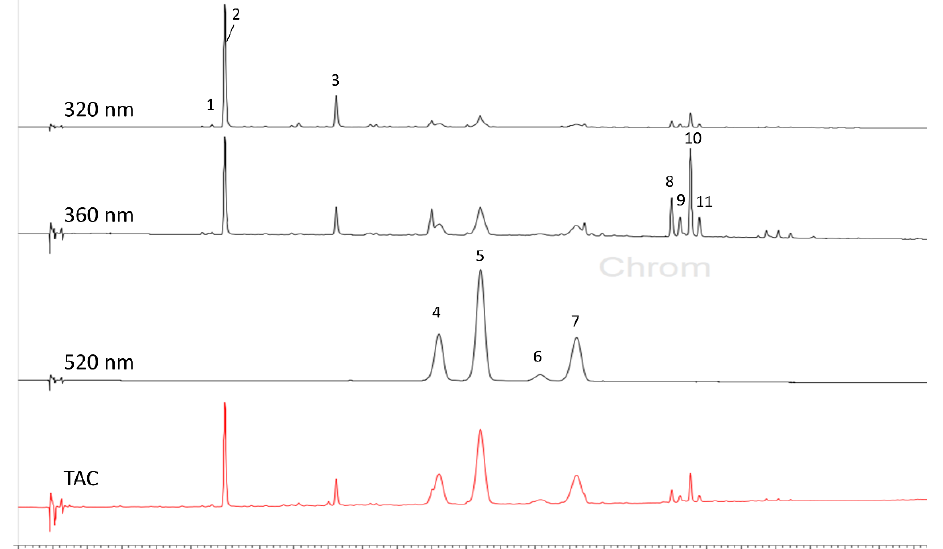
Figure 2. HPLC–DAD chromatogram of the methanol extract of the fruit skins of the plum cultivar “ Č a č anska Lepotica” grown on “GXN 15” rootstock at 320, 360, and 520 nm. For the peak identifi- tivar “ ˇCaˇcanska Lepotica” grown on “GXN 15” rootstock at 320, 360, and 520 nm. For the cation, see Table 3.